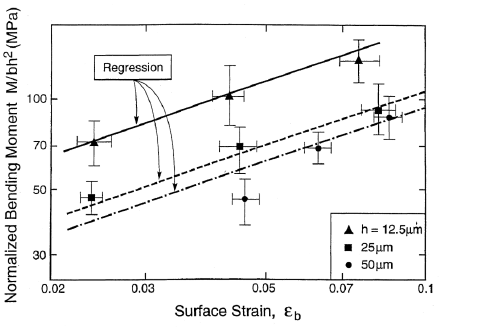
Figure 4. Variation of the normalized bending moment on thin Nickle foils during micro-bending test